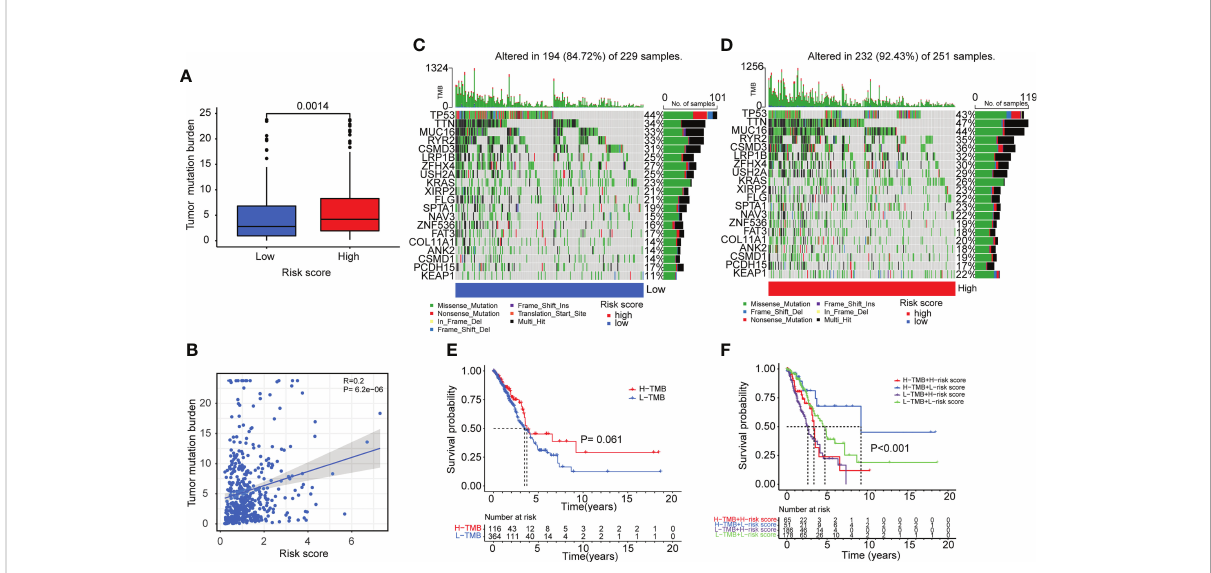
FIGURE 8 Tumor mutation burden analyses in lung adenocarcinoma patients. (A, B) Boxplot and correlation plot showed the relation of tumor somatic mutation with risk score in lung adenocarcinoma patients. (C, D) The summary charts illustrated the distribution of the top 20 tumor somatic mutations in the high-risk and low-risk groups. (E) The survival status and survival time difference between the high-TMB and low-TMB groups. (F) The Kaplan-Meier analysis showed the survival status and survival time in four subgroups: H-TMB+H-risk score, H-TMB+L-risk score, L-TMB +H-risk score, L-TMB+L-risk